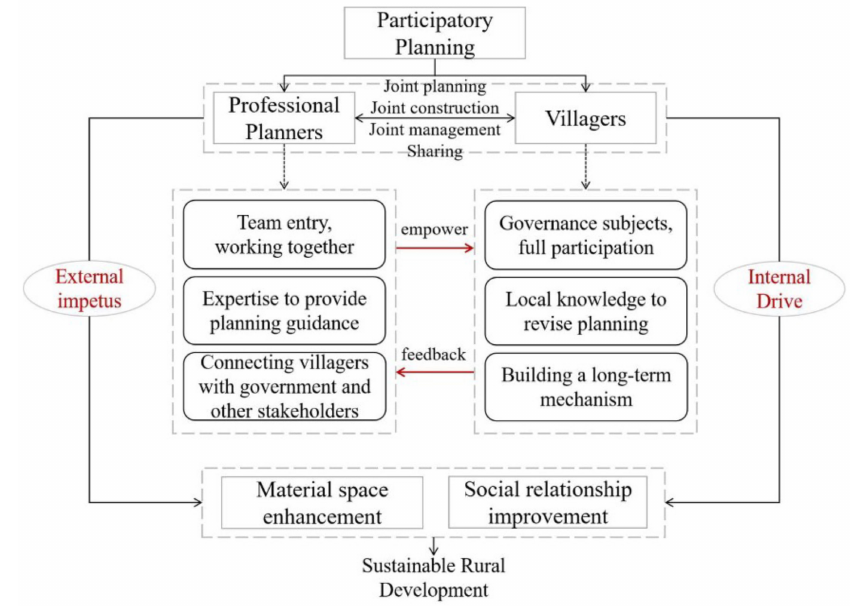
Figure 1. The research framework of this